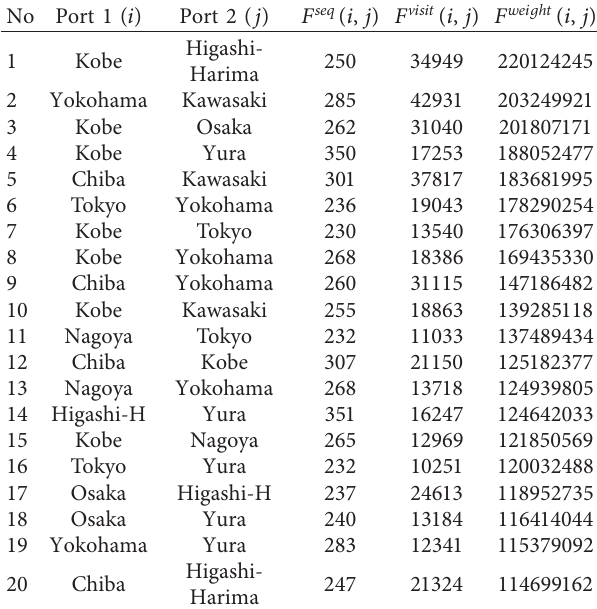
Table 3: Domestic trading connections among Japanese ports.